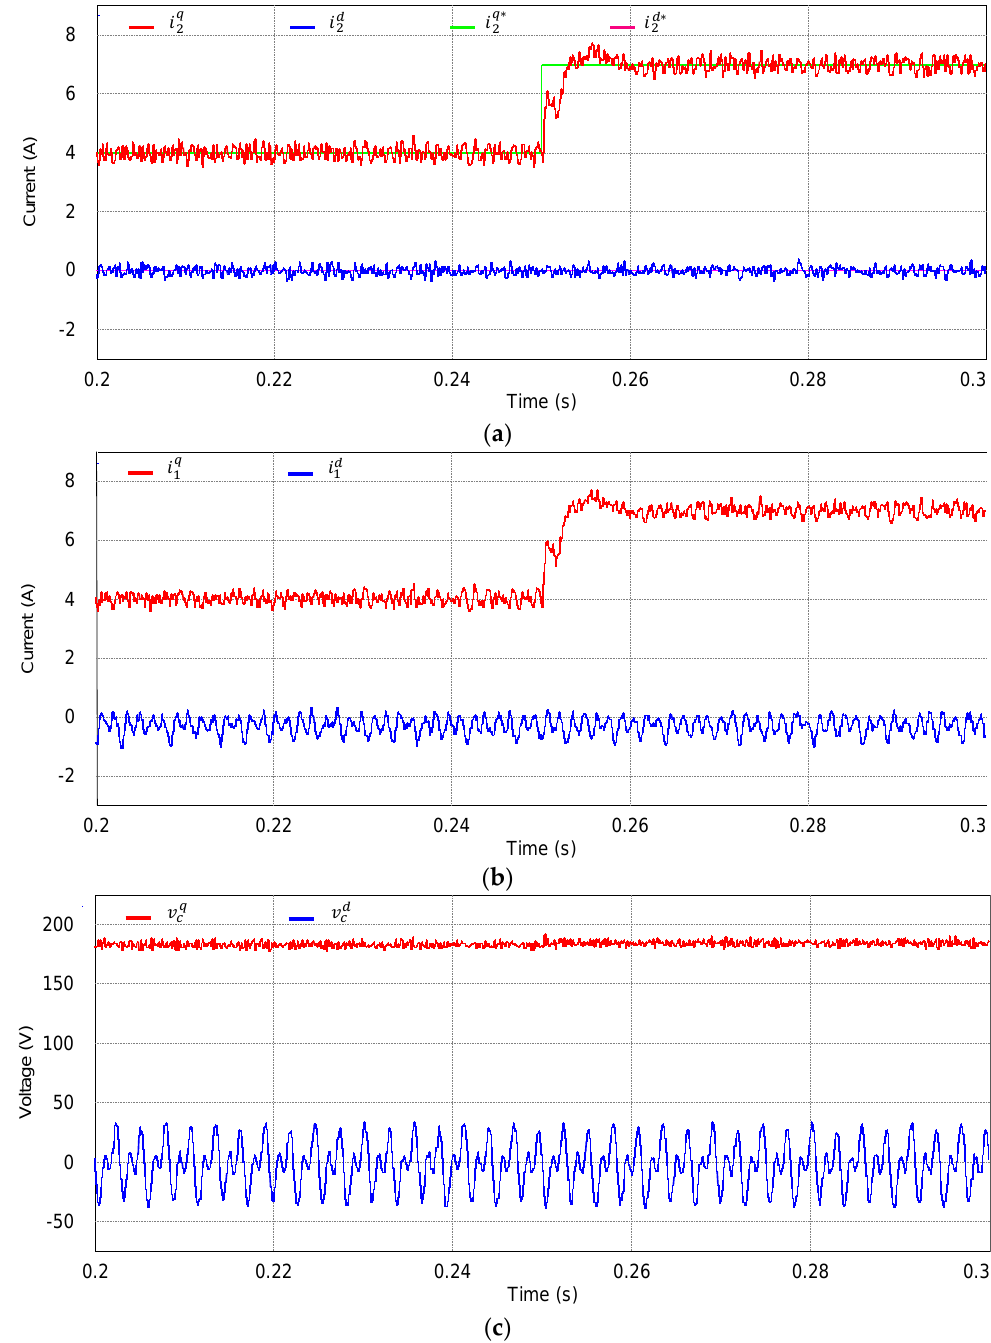
Figure 7. Simulation results for transient responses under distorted grid voltage with the proposed controller. ( a ) Current references and grid-side current responses at the synchronous reference frame (SRF); ( b ) inverter-side current responses at the SRF; ( c ) capacitor voltage responses at the SRF.